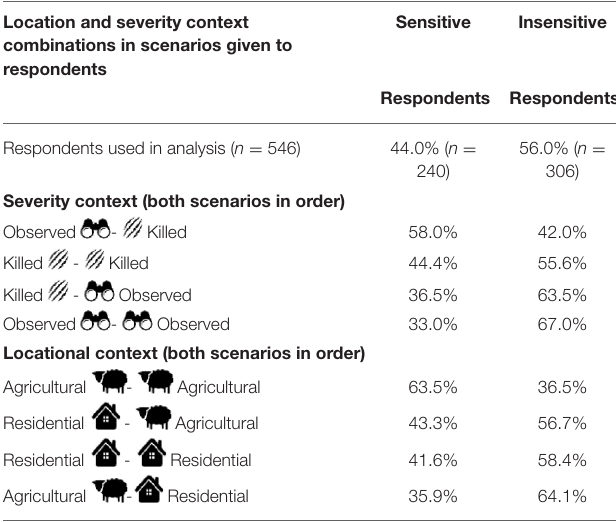
Table 2B | Proportions of contextually sensitive and insensitive responses from each possible carnivore scenario combination. Location and severity context combinations in scenarios given